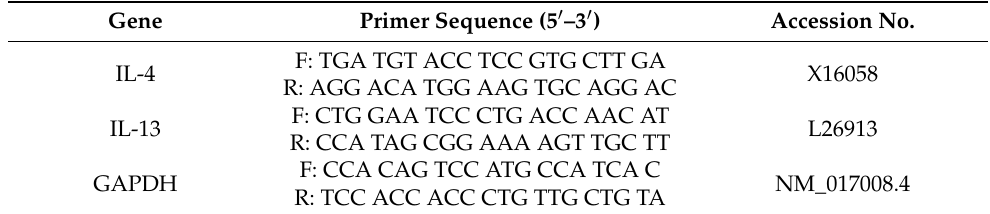
Table 3. Oligonucleotide primer sequences used for quantitative real-time polymerase chain reaction. Gene Primer Sequence (5 (cid:48) –3 (cid:48) )